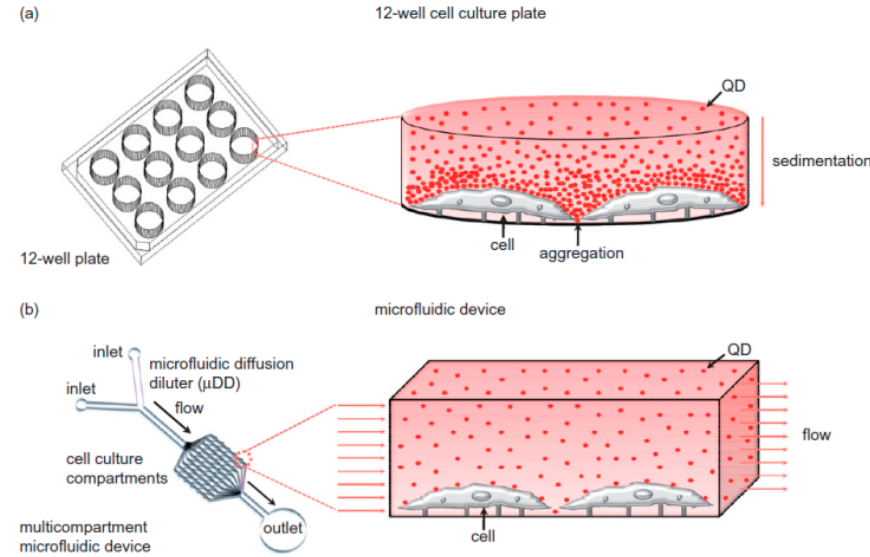
Figure 5. Diagram of nanoparticle behaviour inside well plates vs. microfluidic channel. ( a ) Well-plates without flow have particles aggregate under gravity, causing heterogeneous concentrations; ( b ) microfluidics can keep particles in homogenous suspension while under flow. Reprinted from Biomicrofluidics 4(2010) Mahto, Yoon [60], with the permission of AIP Publishing.